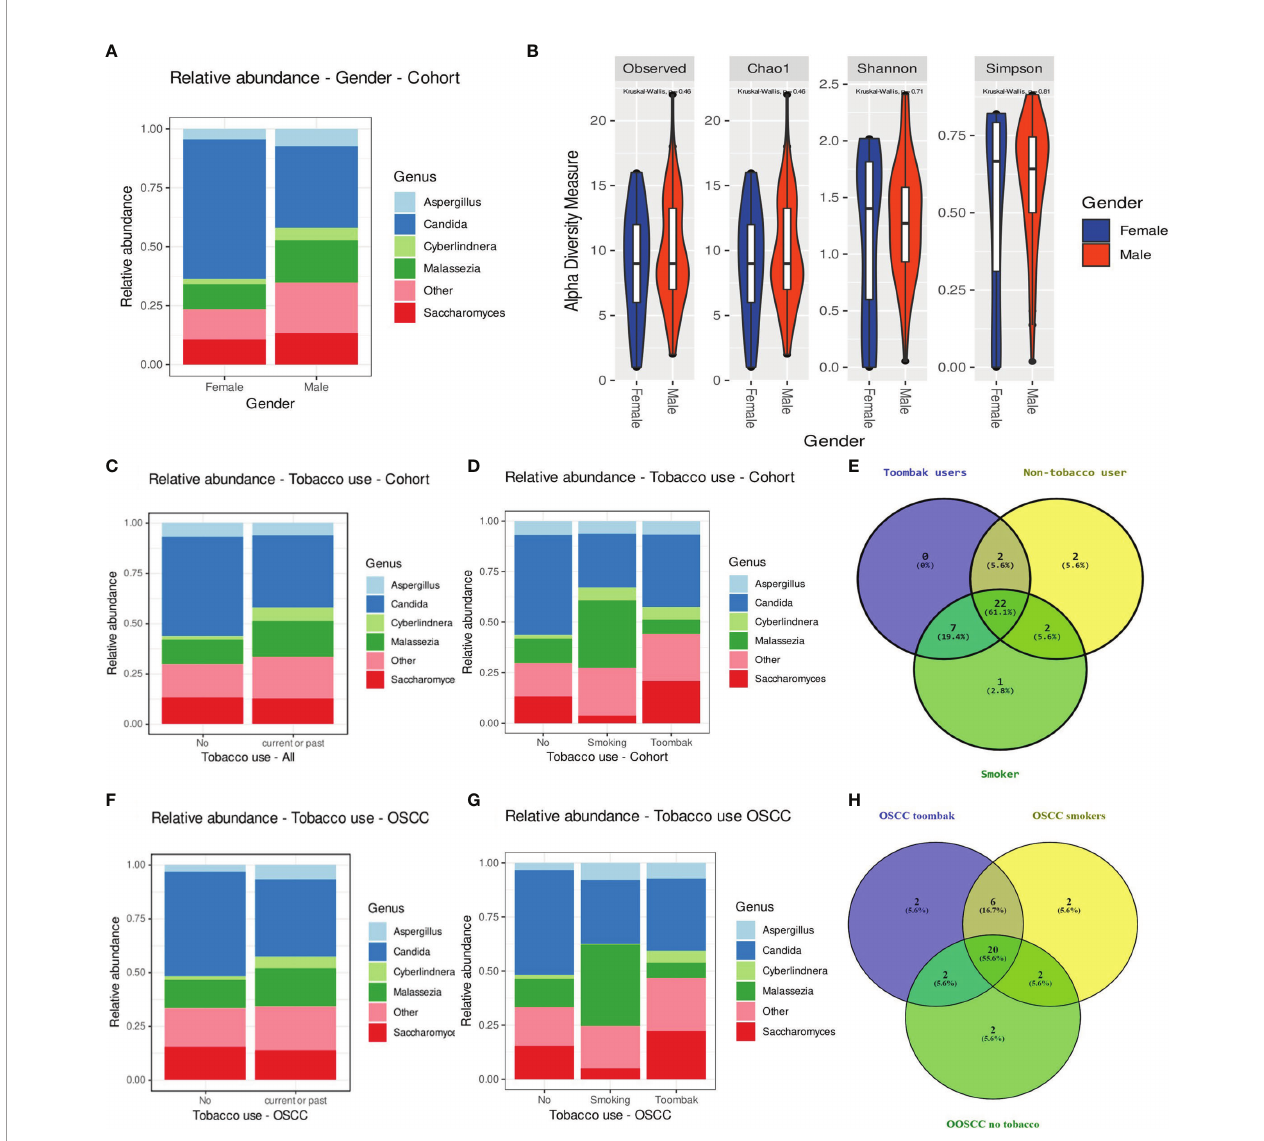
FIGURE 2 | (A, B) Relative abundance of the top fi ve genera (A) and diversity of the salivary mycobiome (B) of the individuals investigated in our cohort grouped by gender. (C) Relative abundance of the top fi ve genera in tobacco users versus non-smokers. (D) Relative abundance of the top fi ve genera in smokers, toombak users, and non-smokers. (E) Venn diagram showing the distribution of genera in smokers, toombak users, and non-smokers. (F) Relative abundance of the top fi ve genera in tobacco users versus non-smokers in the oral squamous cell carcinoma (OSCC) group. (G) Relative abundance of the top fi ve genera in smokers, toombak users, and non-smokers in the OSCC group. (H) Venn diagram showing the distribution of genera in smokers, toombak users, and non-smokers in the OSCC